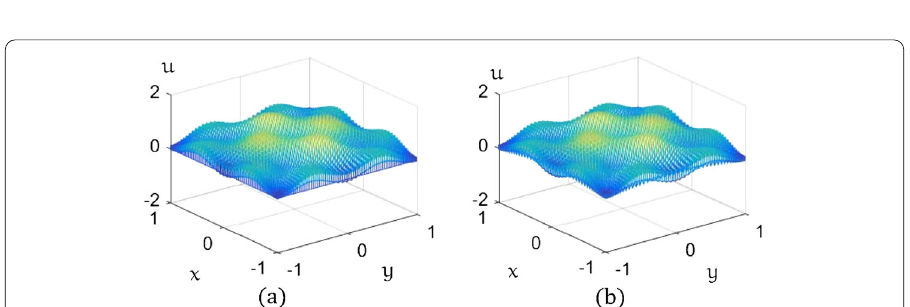
Figure 4 ( a ) The genuine solution when t = 0.9. ( b ) The CNFE solution when t = 0.9